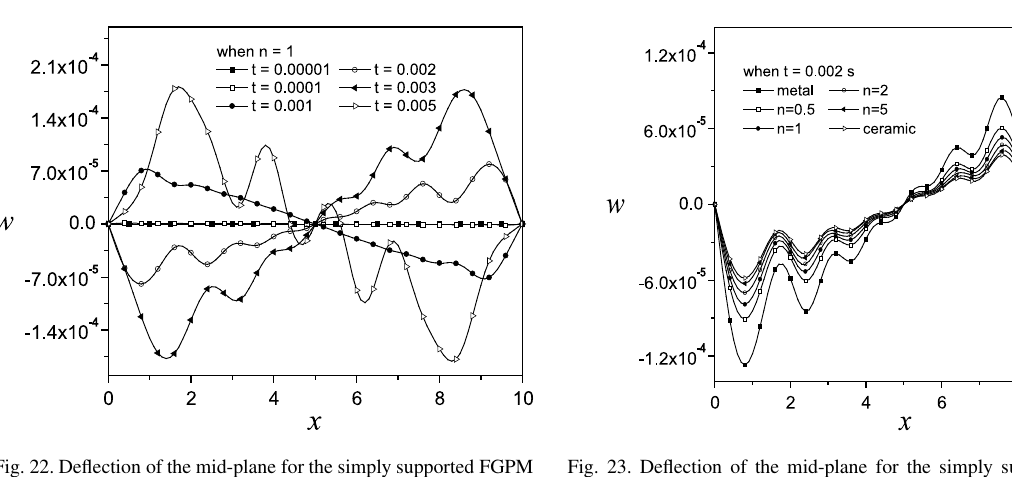
Fig. 22. Deflection of the mid-plane for the simply supported FGPM cylindrical shell imposed by a cosine distributed load, when n = 1 .